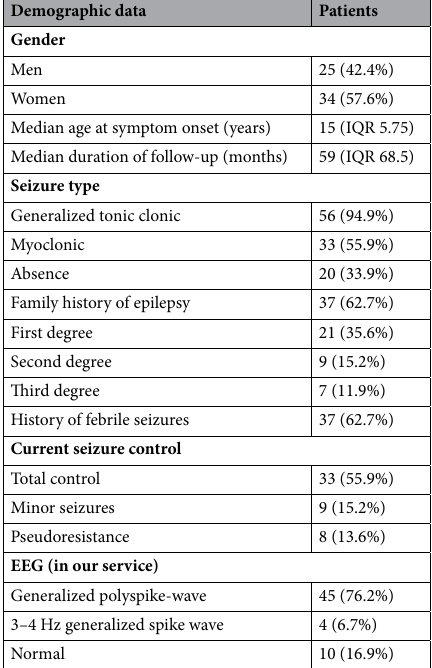
Table 1. Patients’ demographic characteristics.